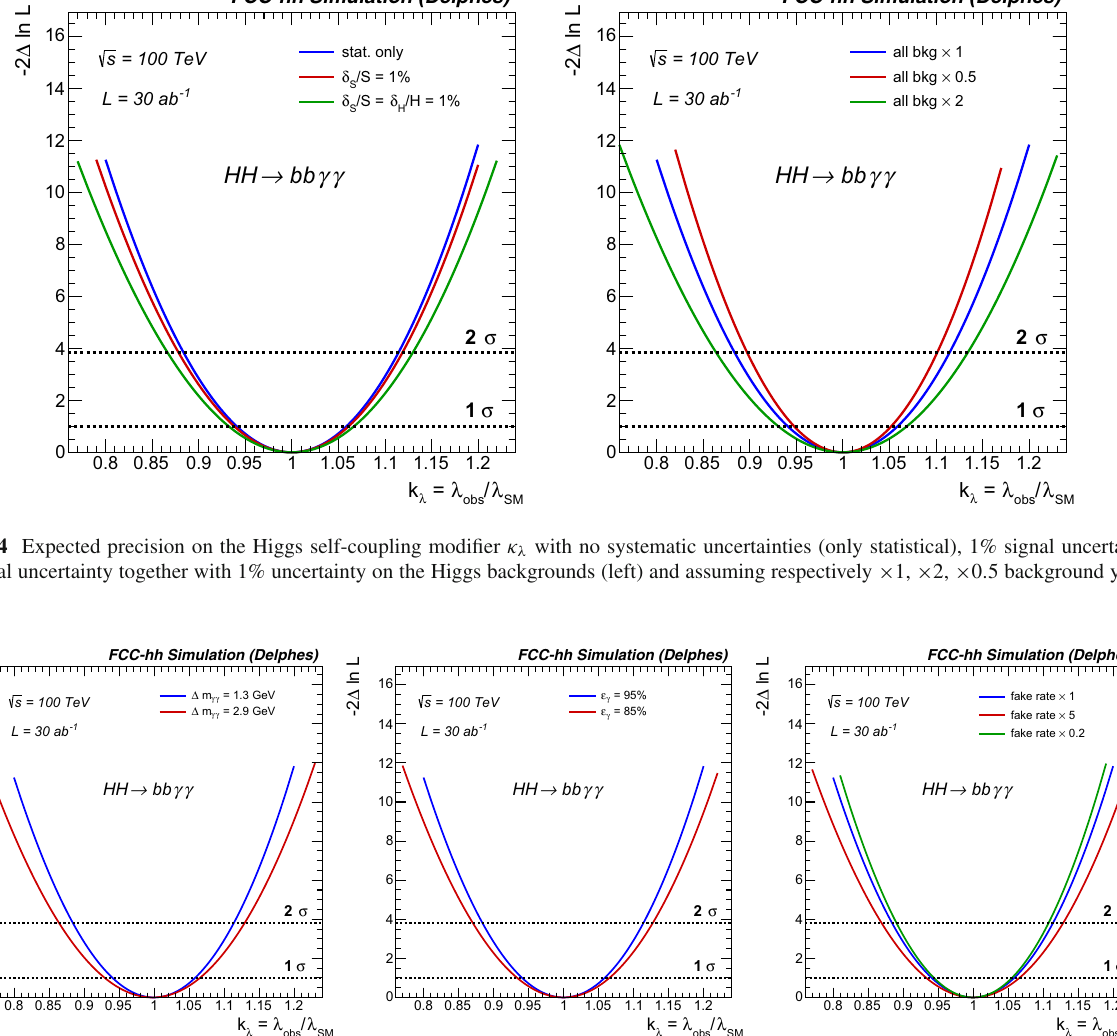
narios with nominal ( (cid:21) γ = 95%) and degraded ( (cid:21) γ = 85%) photon reconstruction efficiency. Right: comparison of three scenarios with nominal, degraded ( × 5) and improved ( × 0 . 2) photon mistag rate